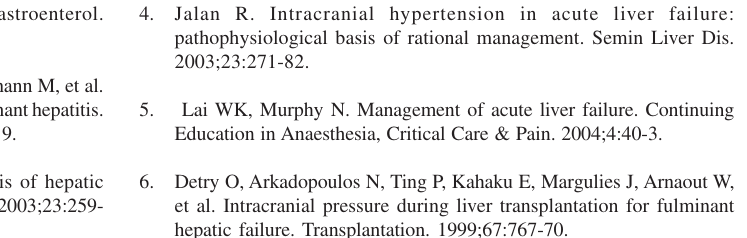
fígado. Reperfusão. Anestesia. Insuficiência hepática. Encefalopatia Hepática. Hipertensão